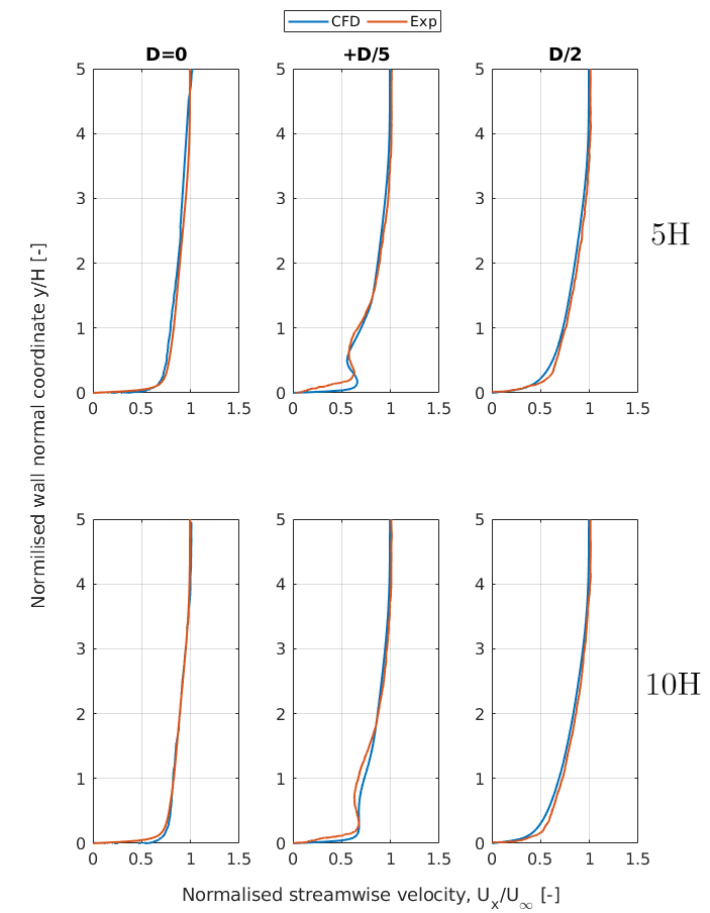
Figure 8. Normalized streamwise velocity profiles for the Triangular VG at two different streamwise locations 5H ( top ), 10H ( bottom ) from the trailing edge of the VG. Distance D = 30 mm corresponds with Figure